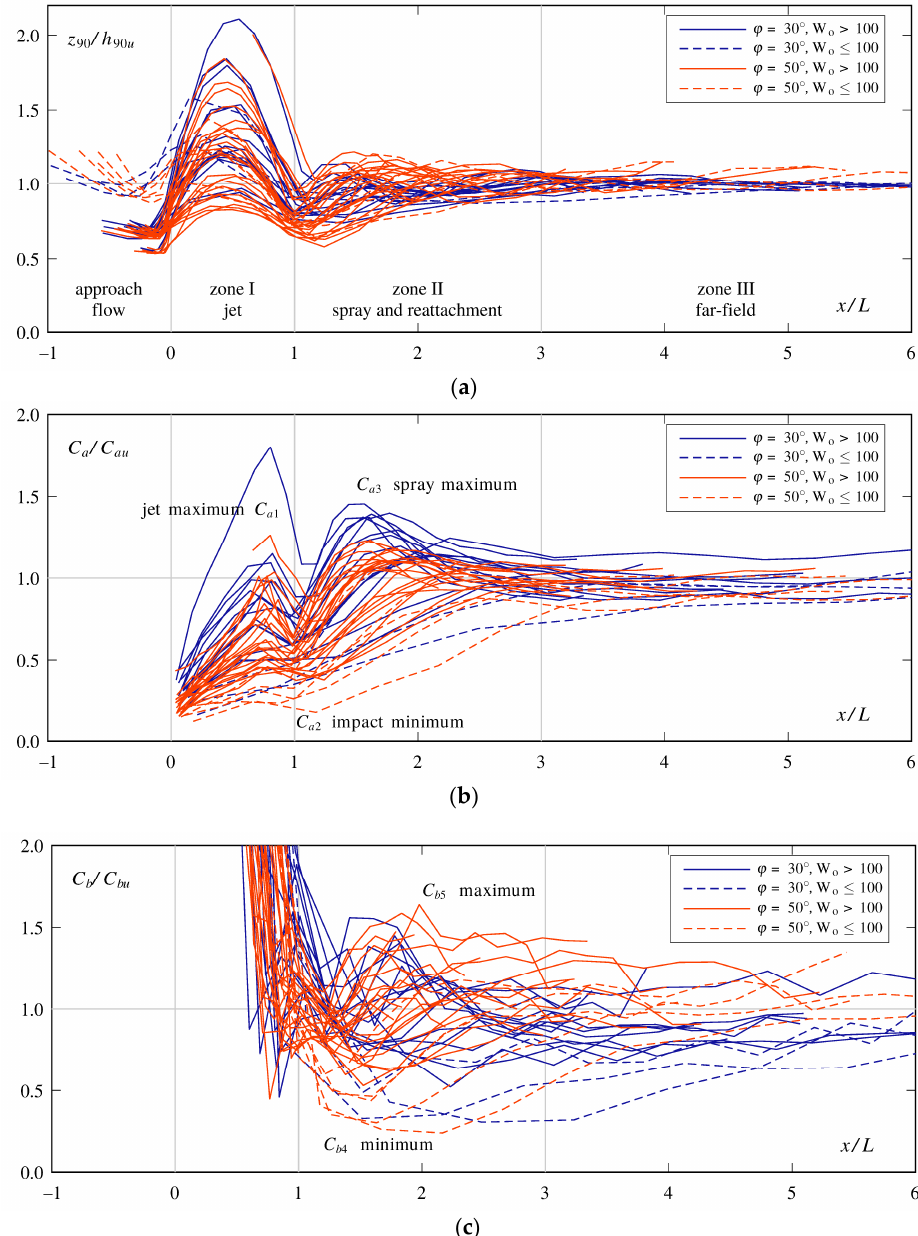
Figure 5. Development of the ( a ) flow surface elevation z 90 , ( b ) average air concentration C a and ( c ) bottom air concentration C b in the different flow zones along the chute. Blue lines are tests with φ = 30° and orange lines are tests with φ = 50°.